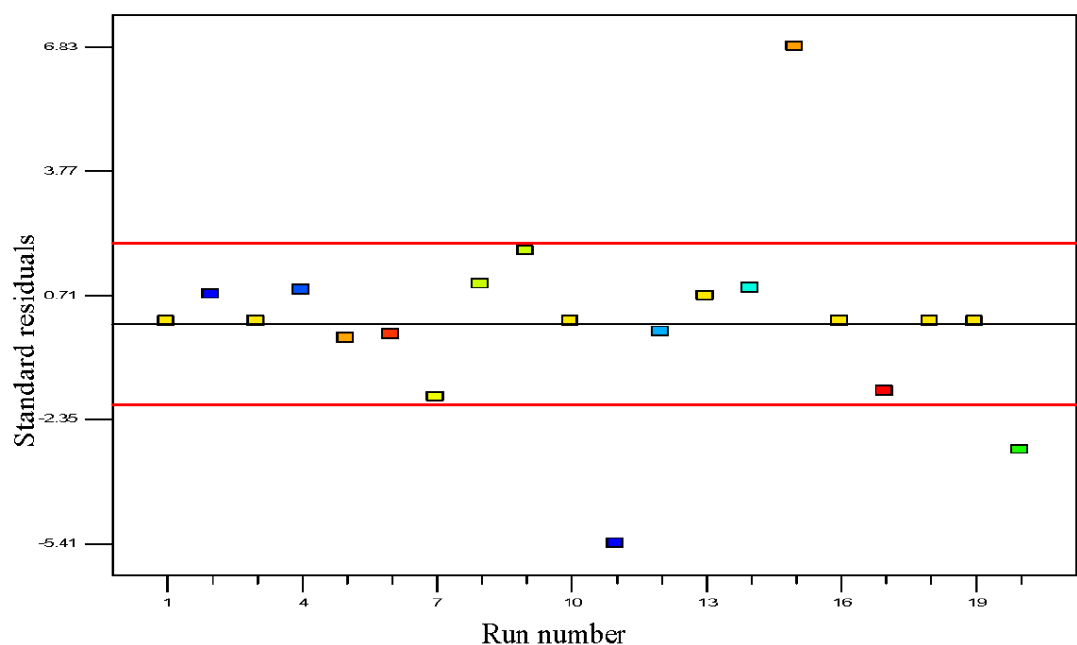
Figure 6. Outlier t plot for propylene polymerization per